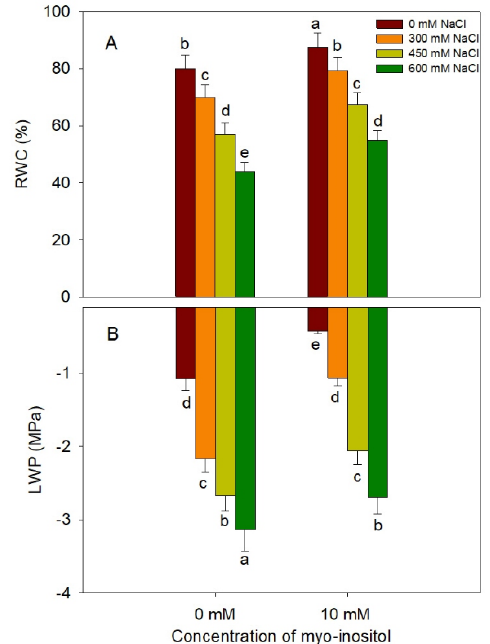
Figure 6. Effect of different salinity (300, 450, and 600 mM NaCl) concentrations with and without exogenous application of myo-inositol (10 mM) on changes in water relations in Quinoa ( Chenopodium quinoa L. var. Giza1). Data expressed as ( A ) relative water content (RWC) (%) and ( B ) leaf water potential (LWP; Mpa). Values are mean (±SE) of four replicates, and different letters represent significant differences at p ≤ 0.05.